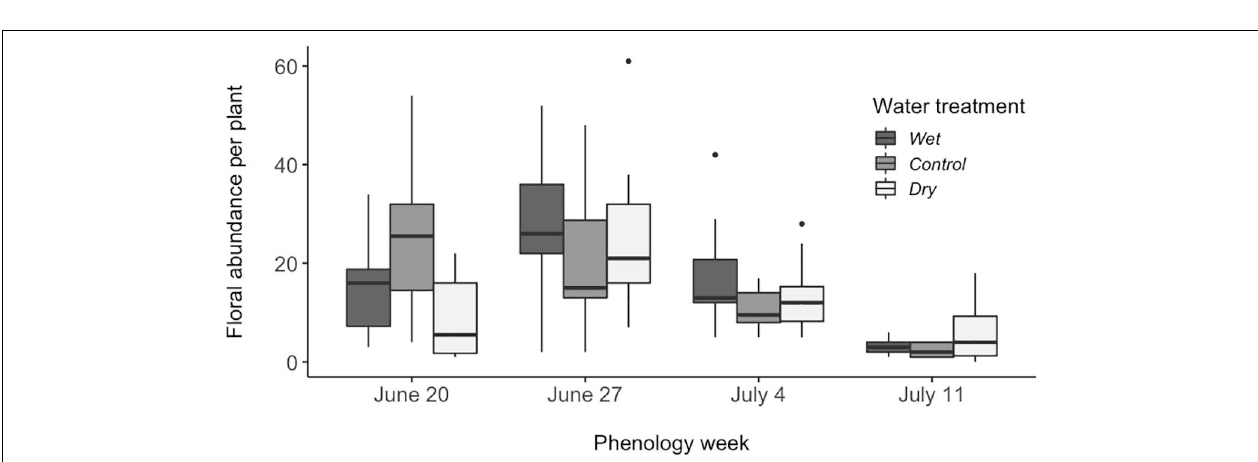
FIGURE 2 | Effects of experimental variation in soil moisture and flowering phenology on (A) corolla width, (B) corolla length, (C) nectar volume, and (D) nectar sugar concentration of Mertensia ciliata. Corolla traits include all four phenology weeks ( N = 106), whereas nectar measurements were only collected for three phenology weeks ( N = 63). (A–C) Wet differed from control and dry treatments (Tukey pairwise comparison among water treatments, P < 0.05). (B) Week 4 (July 11) differed from the earlier 3 weeks (Tukey pairwise comparison among phenology weeks, P < 0.01). Boxplots follow the same conventions as in Figure 1 .